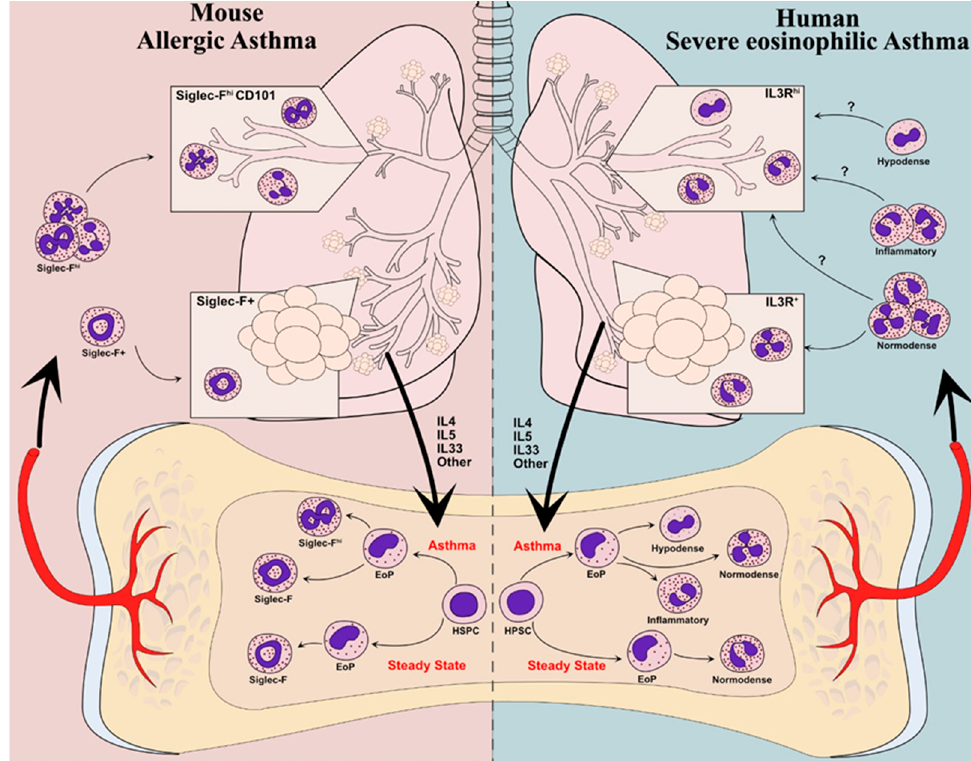
Figure 1. Developmental “endotyping” of murine and human eosinophils in asthma. In mice ( left panel), eosinophils in the steady state populate the lung parenchyma but do not infiltrate the bronchial mucosa. In models of allergic asthma, type-2 inflammatory cues, including IL-5, promote the differentiation of eosinophil progenitors (EoPs) into large numbers of “inflammatory” SiglecF hi eosinophils that infiltrate the bronchial mucosa. In humans ( right ), patients with severe eosinophilic asthma harbor hypodense eosinophils that are most likely derived from the altered development of eosinophil progenitors in response to inflammatory cues. Whether other eosinophils with an “inflammatory” program develop as in mice remains to be established. The respective contribution of normodense, hypodense, and putative inflammatory eosinophils to mucosal inflamma- tion in human asthma remains to be established. (HSPC: hematopoietic stem and progenitor cell; EoP: eosinophil progenitor).